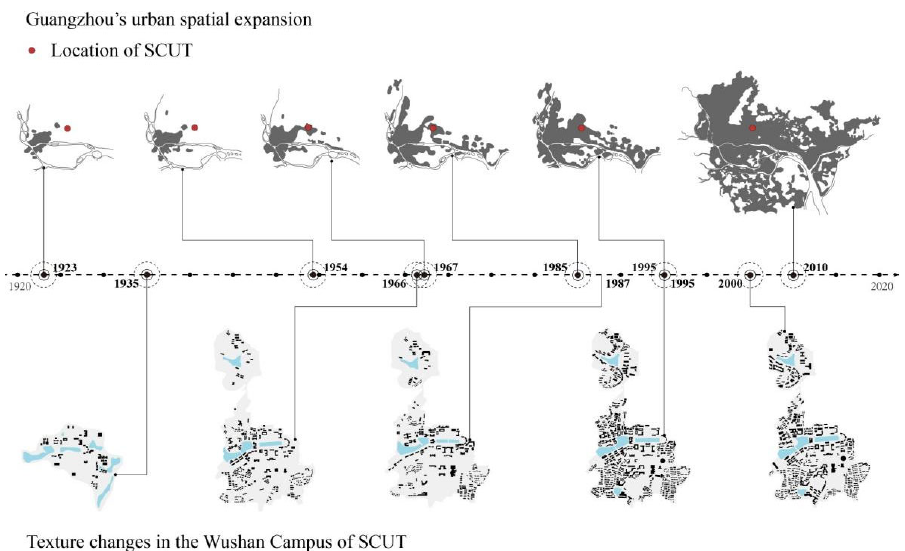
Figure 3. Texture changes in the Wushan Campus of SCUT and the urban spatial relationship in Guangzhou.